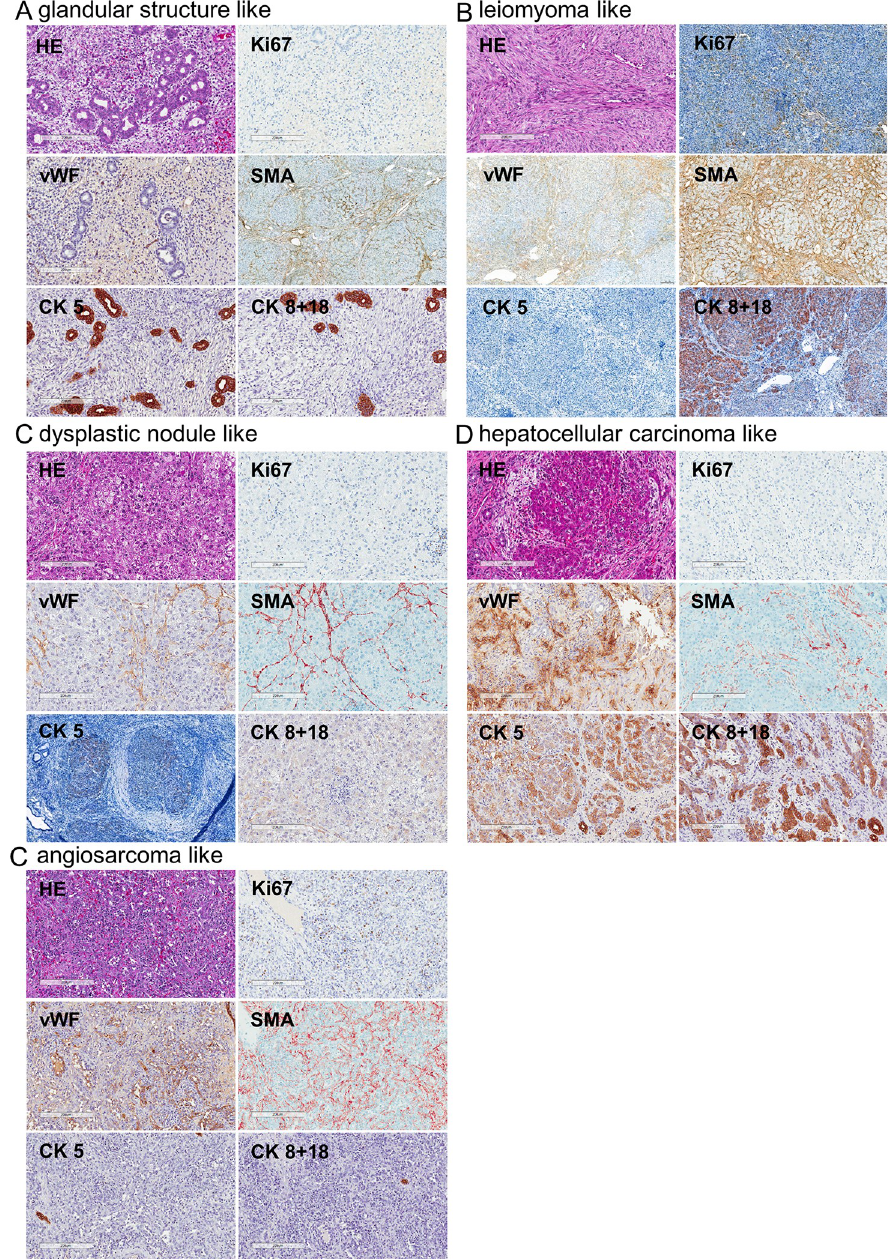
Fig 5. Histology of the different liver lesions. Representative images of treatment group 1 (15 mg/kg DENA weekly) are shown. A) Glandular structure like, B) leiomyoma like tumors C) dysplastic nodule like, D) hepatocellular carcinoma like, and E) angiosarcoma like tumors. Ki67, van Willebrand factor (vWF), cytokeratin 8 and 18 (CK8+18), CK5, and alpha smooth muscle actin (SMA). Scale bars: 200 μ m or 100 μ m for SMA in A, Ki67, vWF, SMA, CK5, and CK8+18 in B, and CK5 in